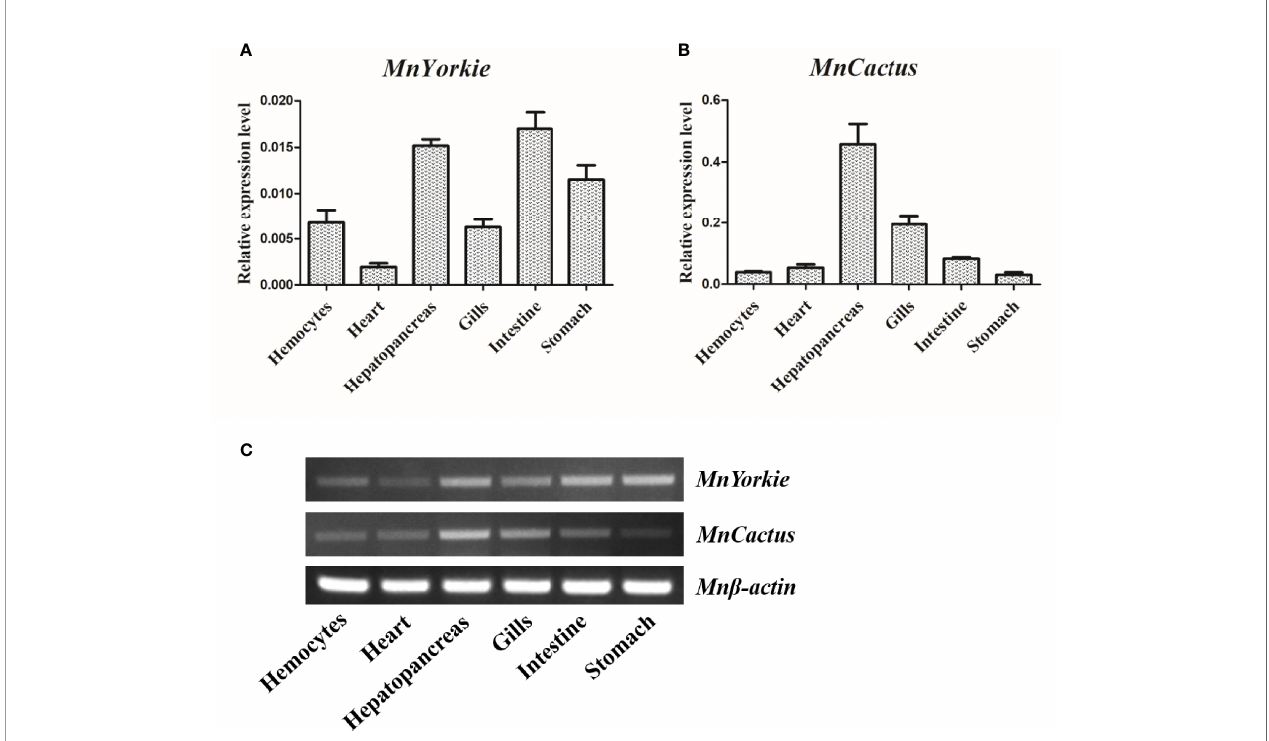
FIGURE 3 | Tissue distributions of MnYorkie and MnCactus in M. nipponense. The relative expression levels of MnYorkie and MnCactus in different tissues (hemocytes, heart, hepatopancreas, gills, intestines and stomach) were measured by RT-qPCR (A, B) and SqRT-PCR (C) . b -actin was used as internal control in all tissues. The values were shown as mean ± SD, N =